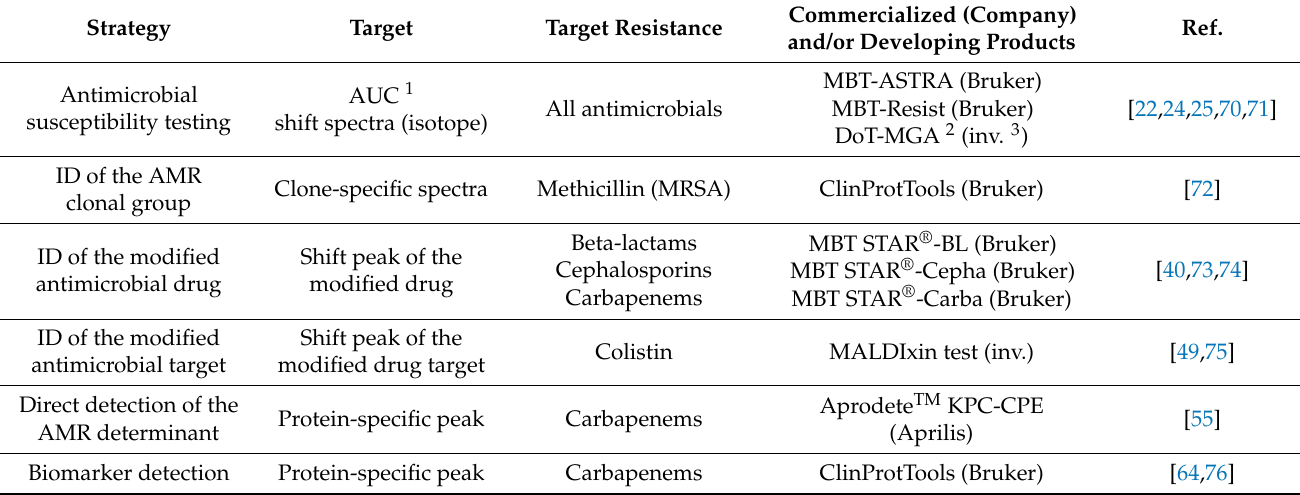
Table 1. MALDI-TOF MS-based rapid diagnostic methods for AMR.